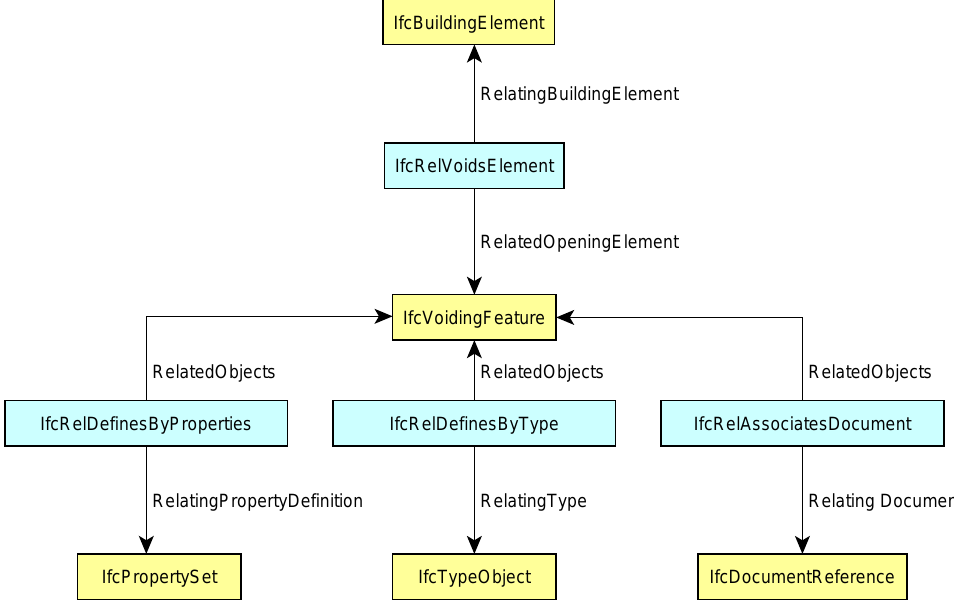
Figure 8. Block diagram of the resultant IFC structure. Yellow elements are instances and blue elements are